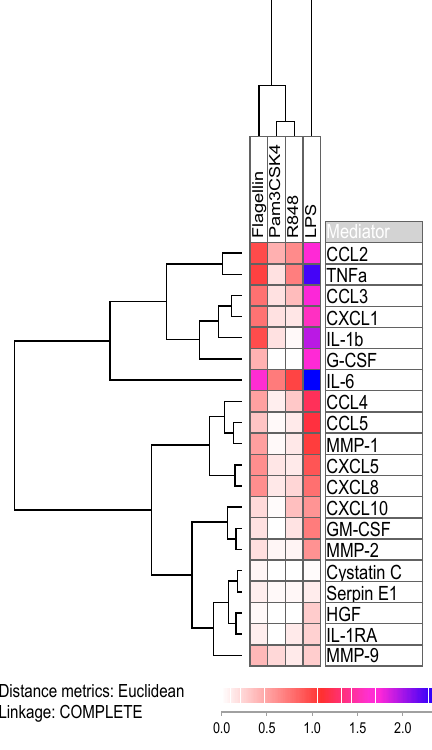
Figure 1. Log-transformed median mediator secretion increase in AML cells after incubation in TLR single agonists for 48 h. For each of the 20 soluble mediators (right part of the figure) we estimated and log-transformed the median effect of the four various TLR agonists (see top of the figure), i.e., the figure is based on the median results for all patients for each agonist/soluble mediator combination. Median values were used in order not to over-estimate the change from low basal levels, and at the same time not to under-estimate the change from basal levels that were close to detection limit of the assay. IL-6 was the most readily upregulated cytokine with medians of 5-fold (Pam3CSK4), 10-fold (R848), 45-fold (flagellin) and 300-fold (LPS) concentration increases. The secretion of the protease inhibitors cystatin C and serpin E1 on the other hand were not altered by TLR ligands.